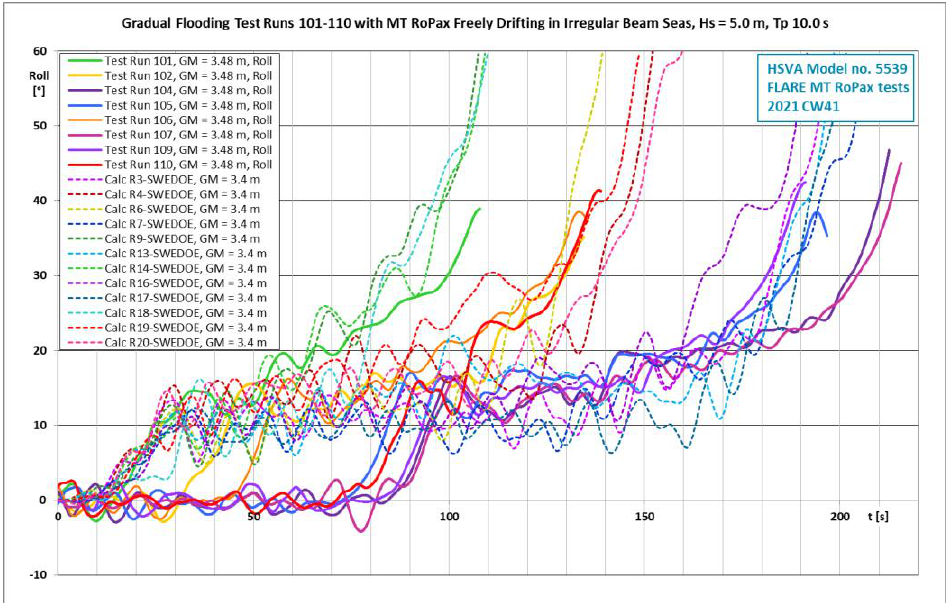
Figure 10. Computed and experimental time histories of the roll angle of the ship in irregular beam